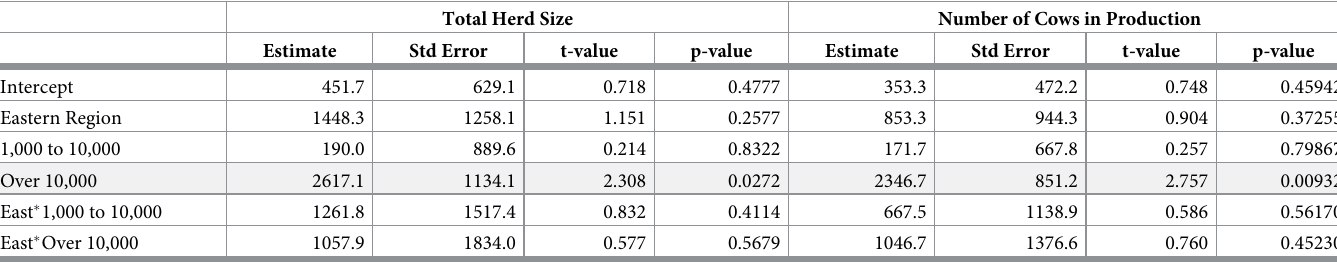
Table 2. Relationship between herd size/cows in production and bird abundance, region, and their interaction. Total Herd Size Number of Cows in Production Estimate Std Error t-value p-value Estimate Std Error t-value p-value